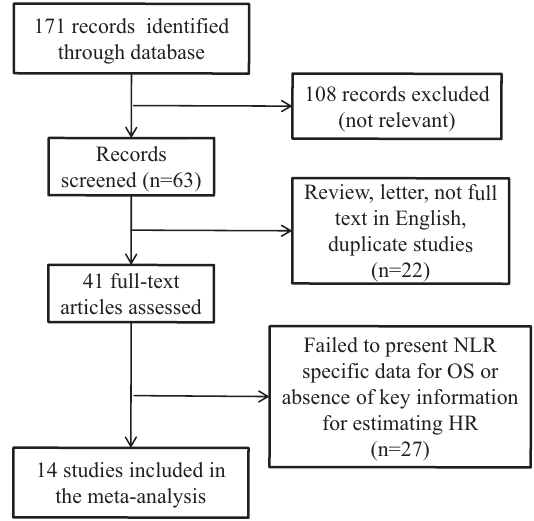
Figure 1 - Methodological flow diagram of the